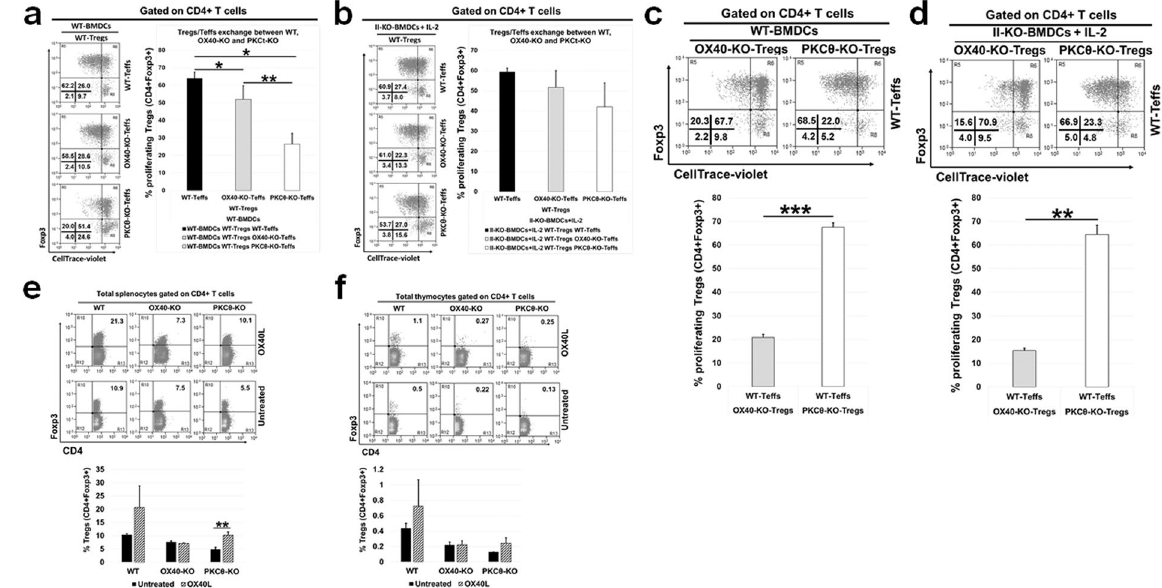
Figure 6. PKC θ -KO Treg proliferation, but not OX40 − / − , phenotype can be rescued when cultured with WT Teffs. ( a – d ) Splenic Tregs (CD4 + CD25 + ) isolated from WT, OX40-KO, and PKC θ -KO mice were labelled with CellTrace violet and then each Treg subtype (WT, OX40-KO & PKC θ -KO) was remixed with the Teffs (CD4 + CD25 − ) from their own counterpart and the other two cell subtypes as indicated. Subsequently, these T-cell combinations were co-cultured with WT-BMDCs or II-KO-BMDCs + IL-2 (1 U/ml) for 4 days then harvested and analysed by flow cytometry. ( a ) Representative dot plots (left) and summarizing bar graphs (right) show the percentage of proliferating Tregs when WT Tregs were remixed with either WT Teffs, OX40-KO Teffs or PKC- θ -KO Teffs then co-cultured with WT-BMDCs. ( b ) Representative dot plots (left) and summarizing bar graphs (right) show the percentage of proliferating Tregs when WT Tregs were remixed with either WT Teffs, OX40-KO Teffs or PKC- θ -KO Teffs then co-cultured with II-KO-BMDCs. ( c ) Representative dot plots (top) and summarizing bar graphs (bottom) show the percentage of proliferating Tregs when OX40-KO or PKC- θ -KO Tregs remixed with WT Teffs then co-cultured with WT-BMDCs. ( d ) Representative dot plots (top) and summarizing bar graphs (bottom) show the percentage of proliferating Tregs when OX40-KO or PKC- θ -KO Tregs remixed with WT Teffs then co-cultured with II-KO-BMDCs. E&F) WT, OX40-KO, and PKC θ -KO mice were treated with soluble OX40L three times (100 µ g/mouse/ week). Another group of mice received PBS (untreated control). One week after the last treatment, mice were euthanized and spleen and thymus were collected for analysis by flow cytometry. ( e ) Representative dot plots show the percentage of Tregs from total CD4 + splenocyte T-cells (left) and summarizing bar graphs (right). ( f ) Representative dot plots show the percentage of Tregs from total CD4 + thymocyte T-cells (left) and summarizing bar graphs (right). Values showing average ± SD, * P < 0.05, ** p < 0.005, and *** p <